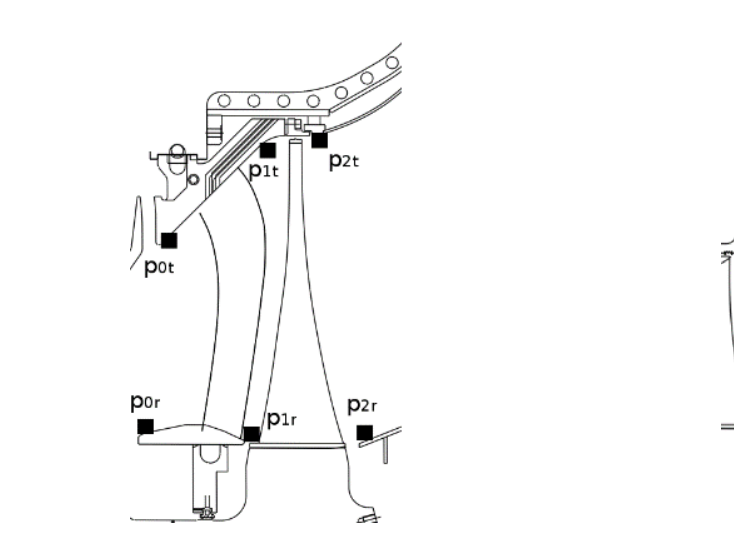
Figure 1. Position of static pressure taps. Figure 2. Position of traversing